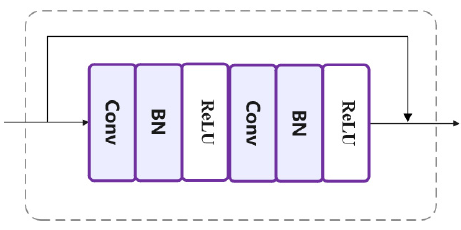
Figure 2. Generator network structure.